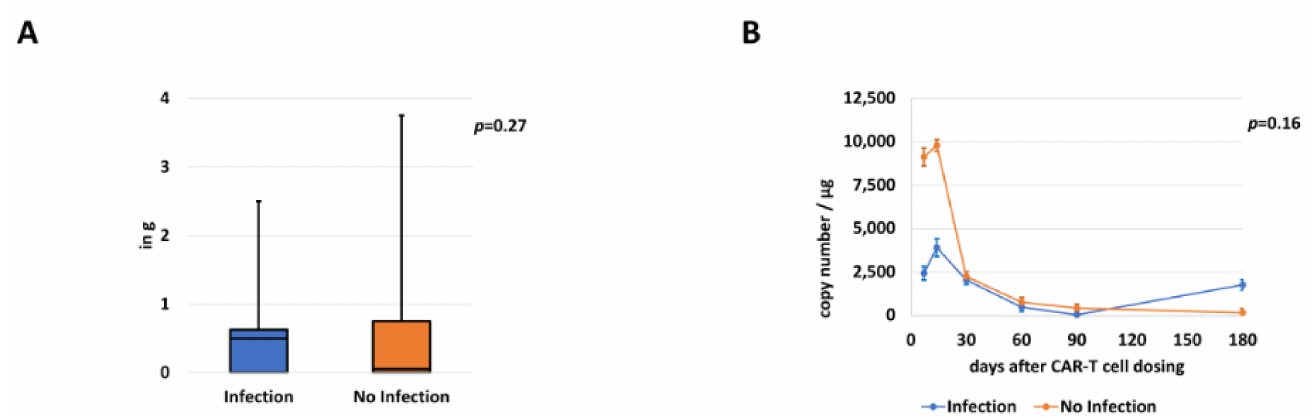
Figure 6. Comparison of cumulative steroid dosages and CAR-T cell expansion (median and CI). Comparison of steroid dosages ( A ) received during hospitalization in patients with or without infection (in gram; g). Additionally, CAR-T expansion levels ( B ) in both subgroups are